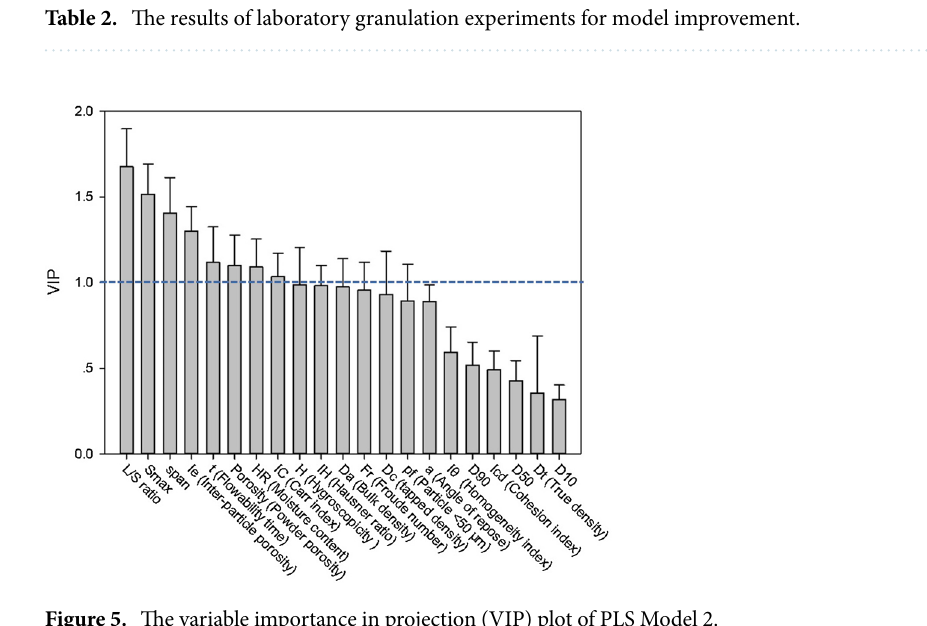
Figure 5. The variable importance in projection (VIP) plot of PLS Model